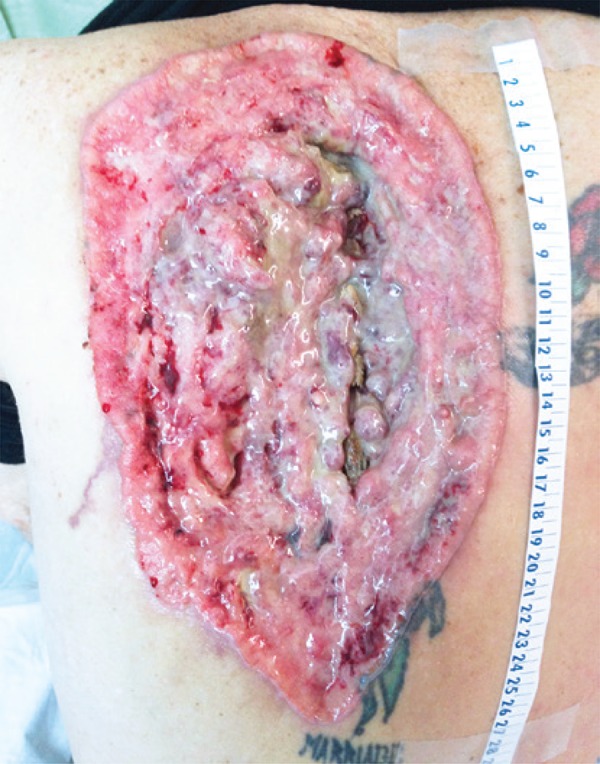
Carcinoma basocelular gigante ulcerado no alto do dorso medindo 26cmx16cm com exposição de musculatura paravertebral e processos espinhosos torácicos. O paciente possuía tatuagem no dorso desde sua adolescência, antes do desenvolvimento da lesão